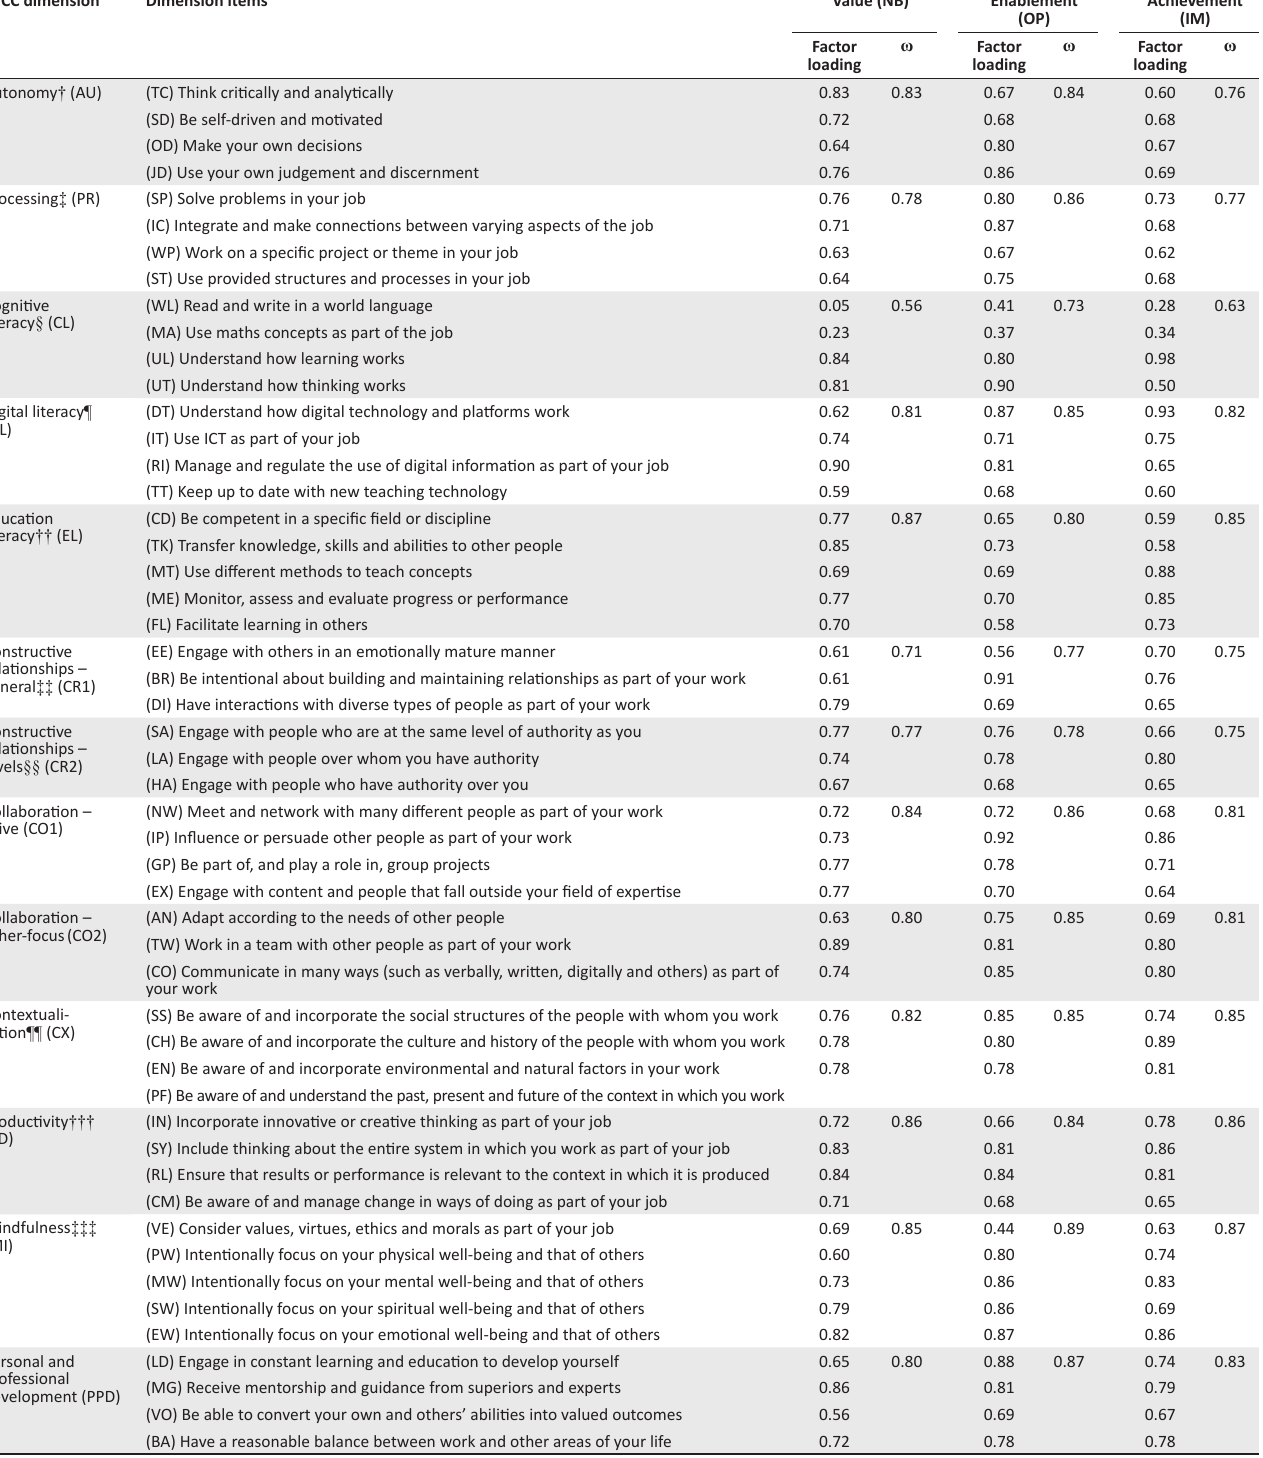
TABLE 4: Factor loadings and reliabilities for the 21st-century competencies as capability dimensions. 21CC dimension Dimension